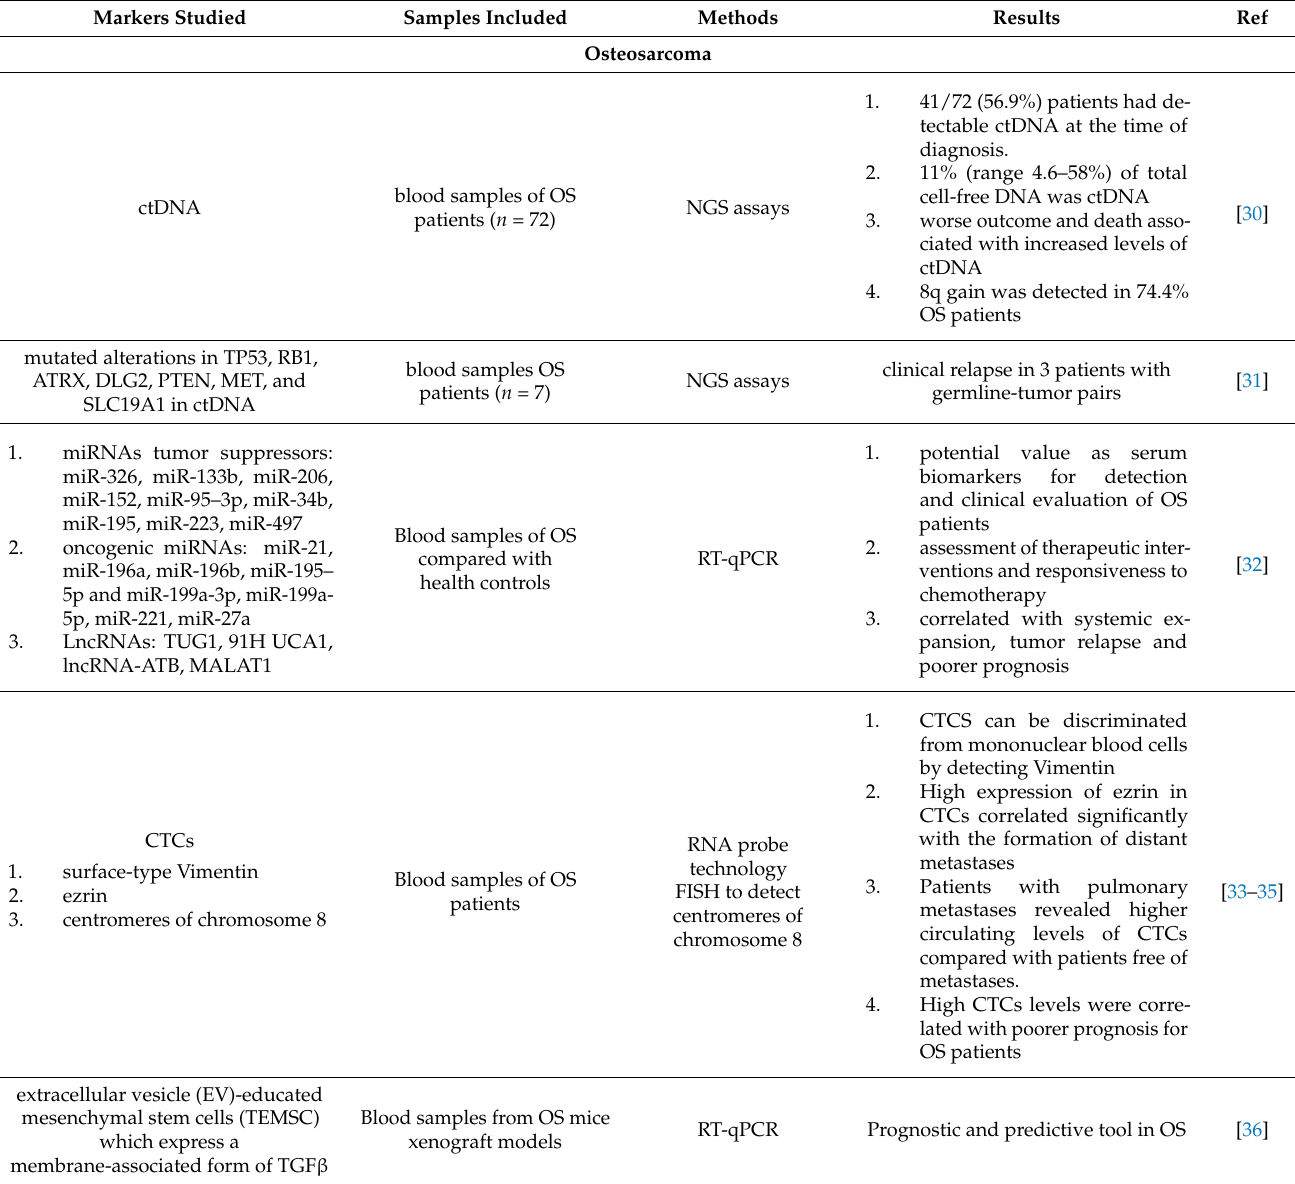
Table 2. Parameters measured through liquid biopsy in bone sarcomas, number of samples, methods used and